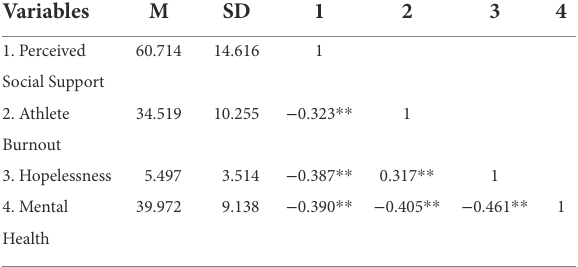
TABLE 1 Descriptive statistics and Pearson correlation coefficients for main study variables ( n =